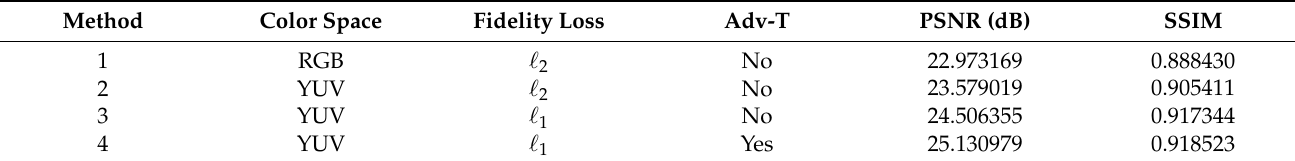
Table 3. Average peak signal-to-noise ratio (PSNR) and similarity index measurement (SSIM) values of images reconstructed with various architectures—the RICE1 test set.